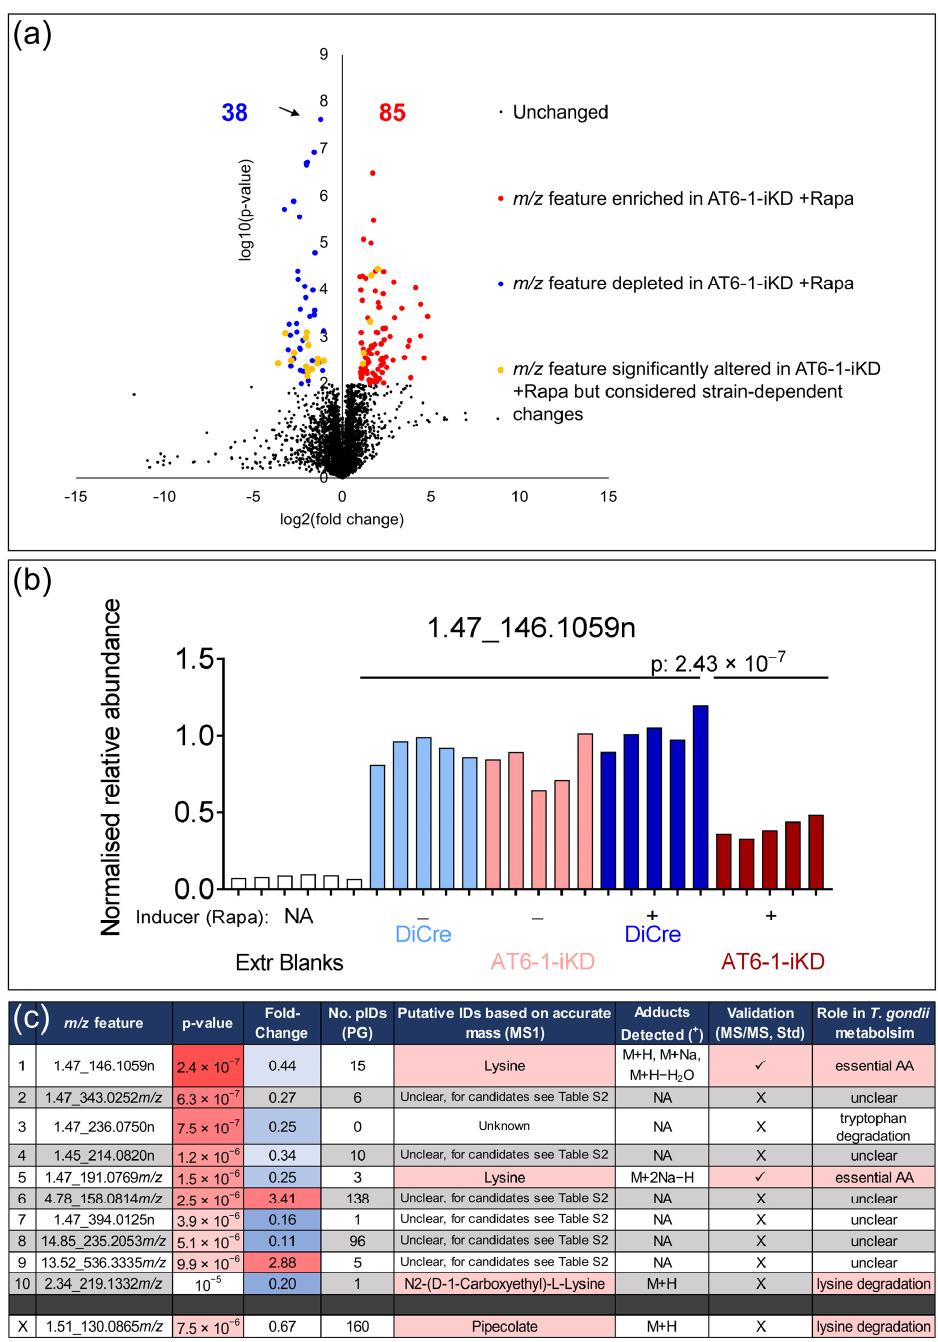
Figure 2. Untargeted metabolomic analysis of T. gondii depleted in AT6-1. ( a ) Volcano plot highlighting the mass features that changed significantly in their abundance ( p < 0.01, fold change > 2) down-regulation of AT6-1 through rapamycin (+R) (2-sided Student’s t-test comparing AT6-1-iKD+R vs. AT6-1-iKD − R/DiCre+/ − R). Inducer-dependent changes (23, yellow) and strain-dependent changes (0) were filtered out, as outlined in the text. ( b ) The most significantly altered metabolite ( p = 2.43 × 10 − 7 ) in AT6-1-iKD+R parasites (see arrow in ( a )) was a mass feature with a neutral mass of 146.1059 eluting at 1.47 min. Its normalized abundance is shown for each independent biological replicate and the extraction blanks. ( c ) A list of the 10 most significantly altered mass features in AT6-1-iKD+R is shown. The p -value and fold-change when comparing AT6-1-iKD+R vs. AT6-1-iKD − R/DiCre+R/DiCre − R are given. The number of putative identifications in Progenesis QI v.2.4 (Waters-NonlinearDynamics) are shown. The most significantly altered feature and the 5th most significantly altered feature were attributed to the essential amino acid lysine. Two additional mass features were putatively attributed to the lysine degradation products (N2-(D-1-carboxyethyl)-l-lysine and